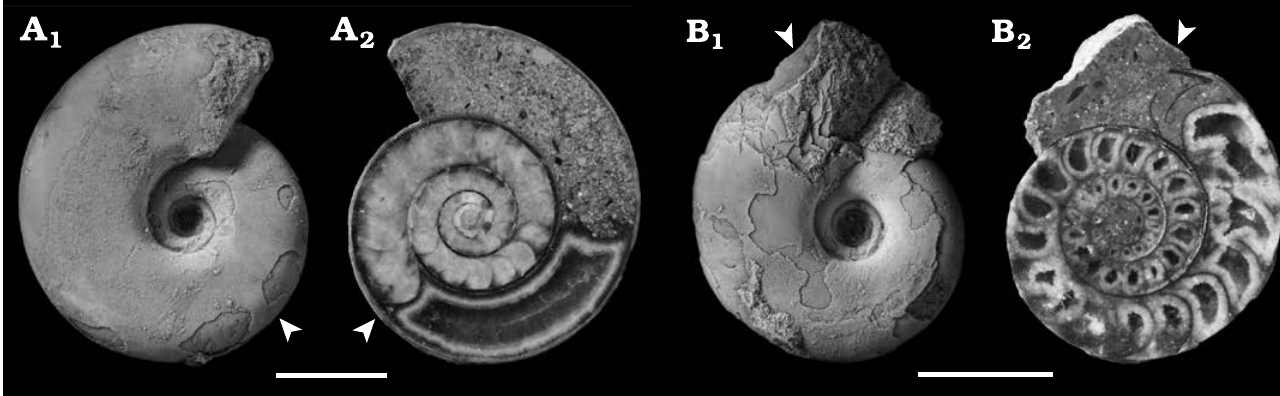
Fig. 8. Two categories of the preservation pattern of the body chamber of tetragonitid ammonoid Tetragonites minimus Shigeta, 1989, from the Santonian, Yezo Group in the Haboro, Kotanbetsu, and Tappu areas, Hokkaido, Japan. A . MCM-W1549, complete or almost intact specimen, note the interiors of the body chamber filled with sparry calcite. B . MCM-W1555, incomplete specimen. In lateral (A 1 , B 1 ) and median section (A 2 , B 2 ) views. Arrowheads indicate the last septum. Scale bars 5